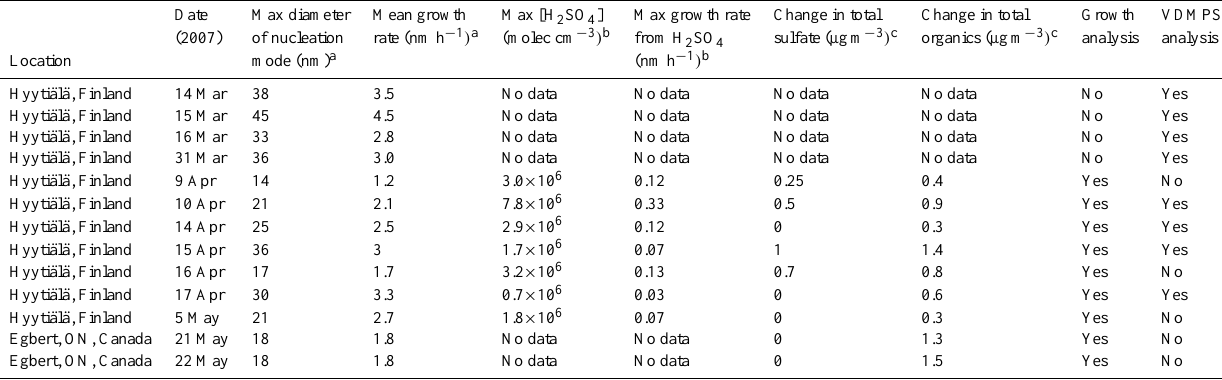
Table 1. Summary of analyzed